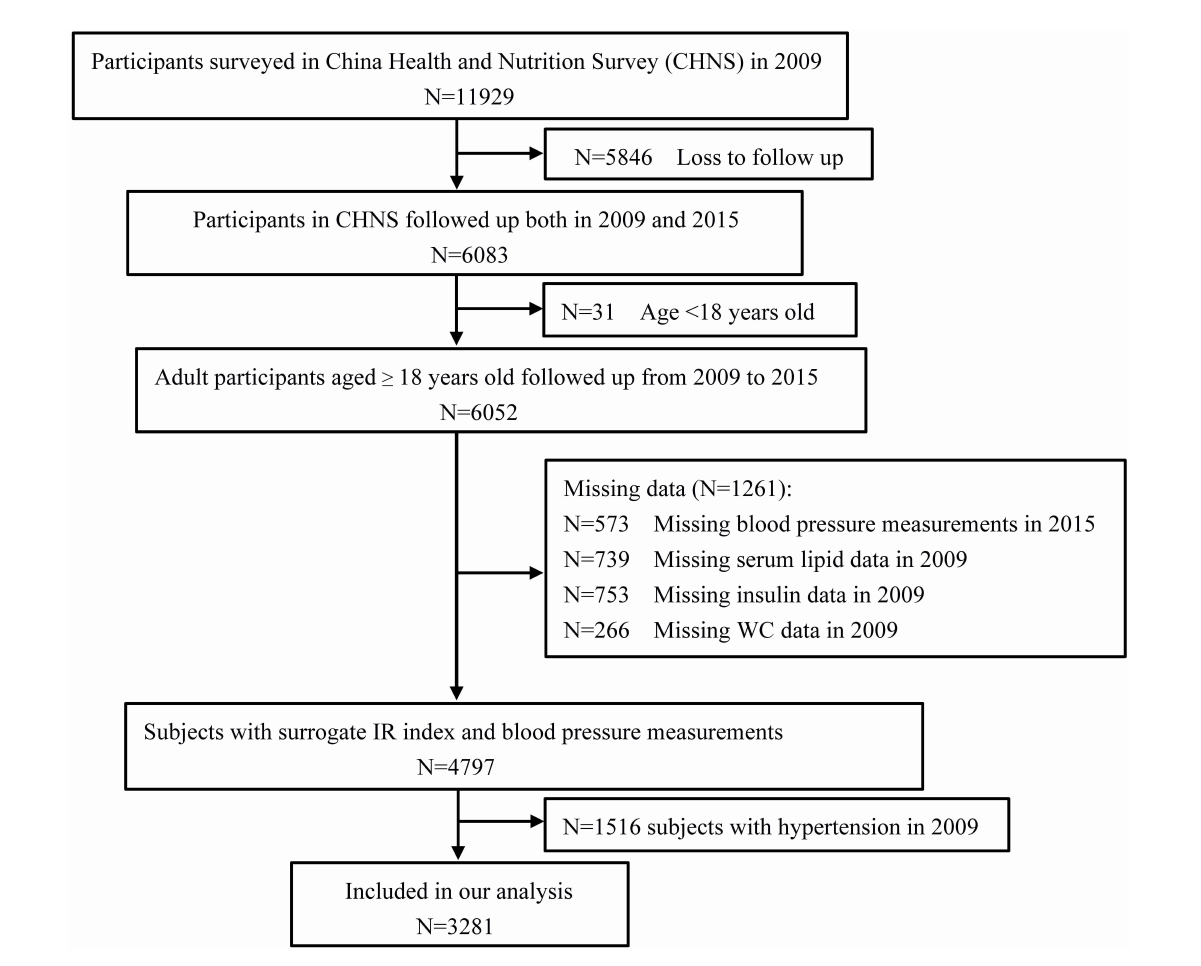
FIGURE1 Flowchart of the study participants from the China Health and Nutrition Survey ( n =